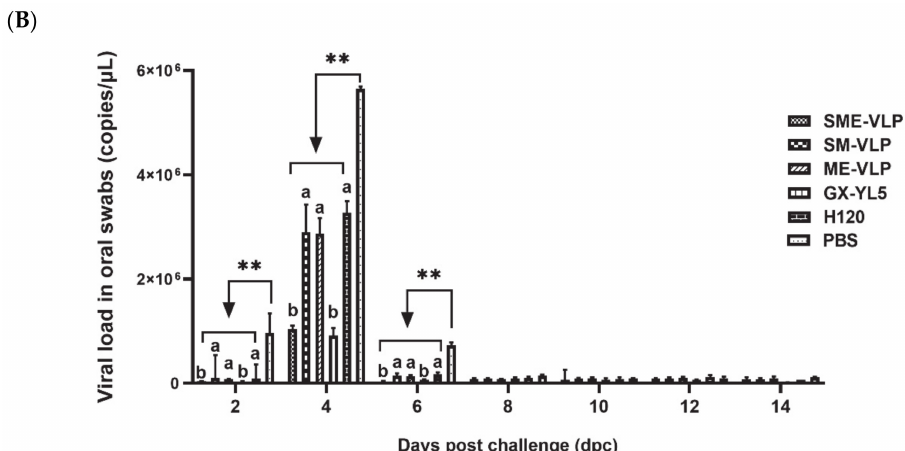
Figure 12. Viral loads in tear and oral swabs. IBV RNA levels in tear and oral swabs were evaluated at 2, 4, 6, 8, 10, 12 and 14 dpc. ( A ) Viral loads in tear swabs. ( B ) Viral loads in oral swabs. Letters (a,b) indicate significant differences among vaccinated groups ( p < 0.05). ** and * indicate p < 0.01 and p < 0.05 between vaccinated and nonvaccinated groups, respectively. ( n = 10 chickens/group.)